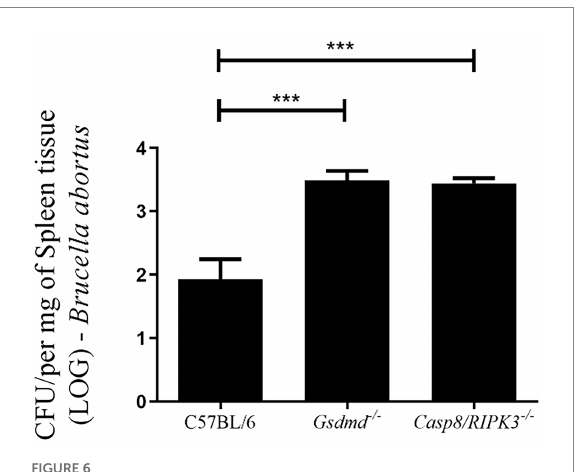
FIGURE 6 Caspase-8 influences the resistance to Brucella infection in vivo . C57BL/6, Gsdmd − / − and Casp8/RIPK3 − / − m ice were infected intraperitoneally with 1×10 6 CFU of B. abortus . Animals were sacrificed 2 weeks after infection and diluted spleen homogenates were plated on agar plates containing BB medium for CFU determination. Data shown are the mean ± standard deviation of five mice/group. The graph is representative of three independent experiments. One-way ANOVA, *** p < 0.001 compared to